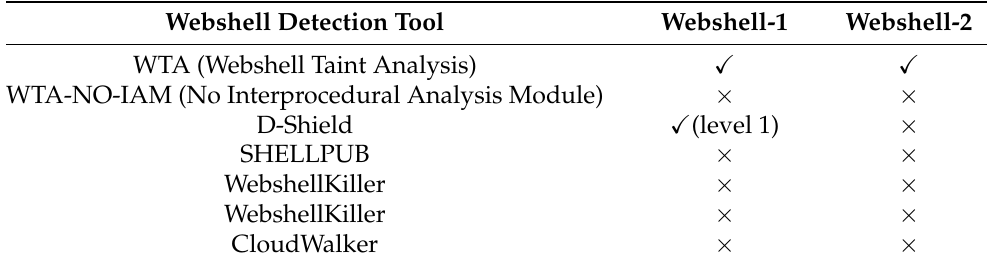
Table 6. Interprocedural analysis of the test code experiment